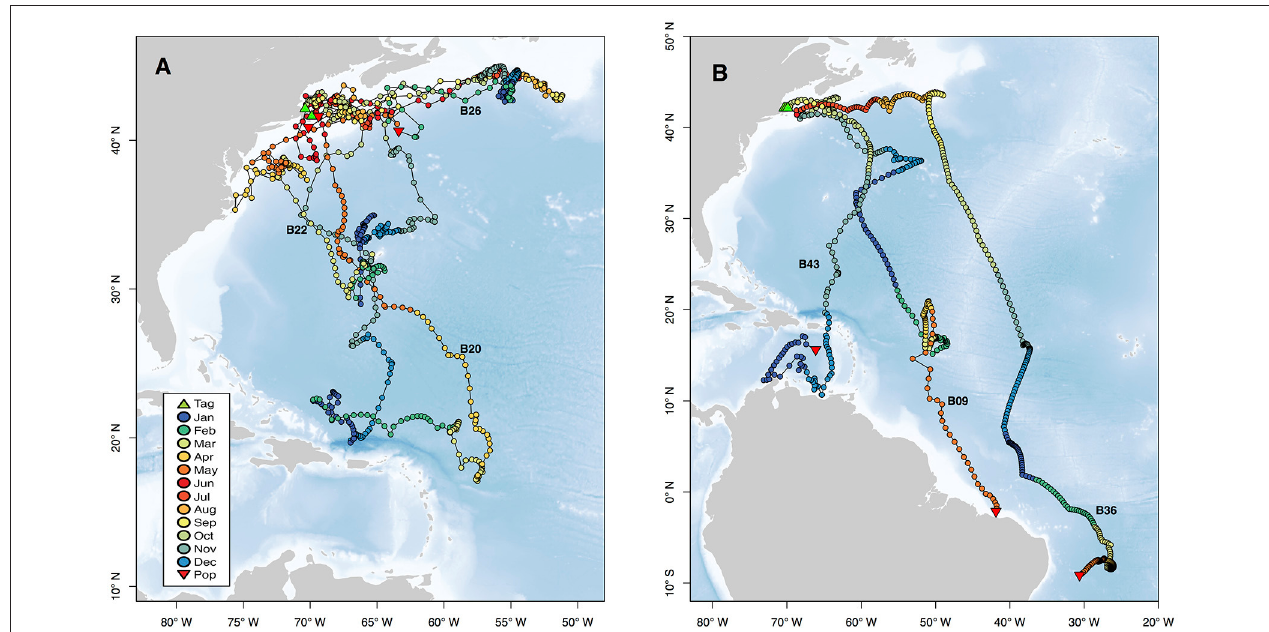
FIGURE 5 | Movements of selected individuals demonstrating representative behaviors exhibited by sharks in this study. Two selected individuals exhibited site fidelity to Cape Cod (B20, B22) and one individual overwintered near Newfoundland (B26, A ). The variety of long distance movements are represented by three individuals with pop-up locations from the eastern Caribbean to the SE coast of Brazil (B) . Tracks are plotted as points colored by month, and green and red triangles represent tag and pop-up locations, respectively. Text labels correspond to Shark ID in Table 1 , and blue background indicates bathymetry of the region. Vertical habitat use of these selected individuals is shown in Figures 4 , 6 .